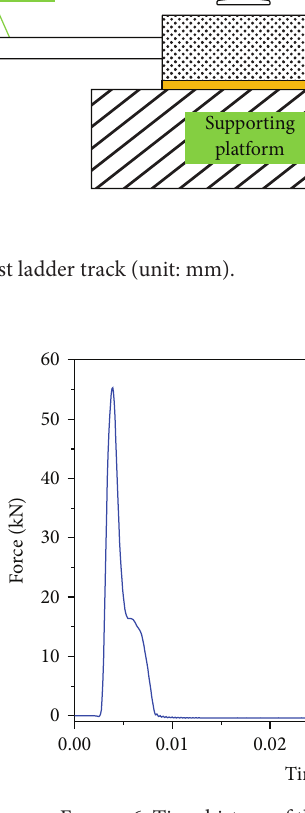
Figure 6: Time history of the average impulse